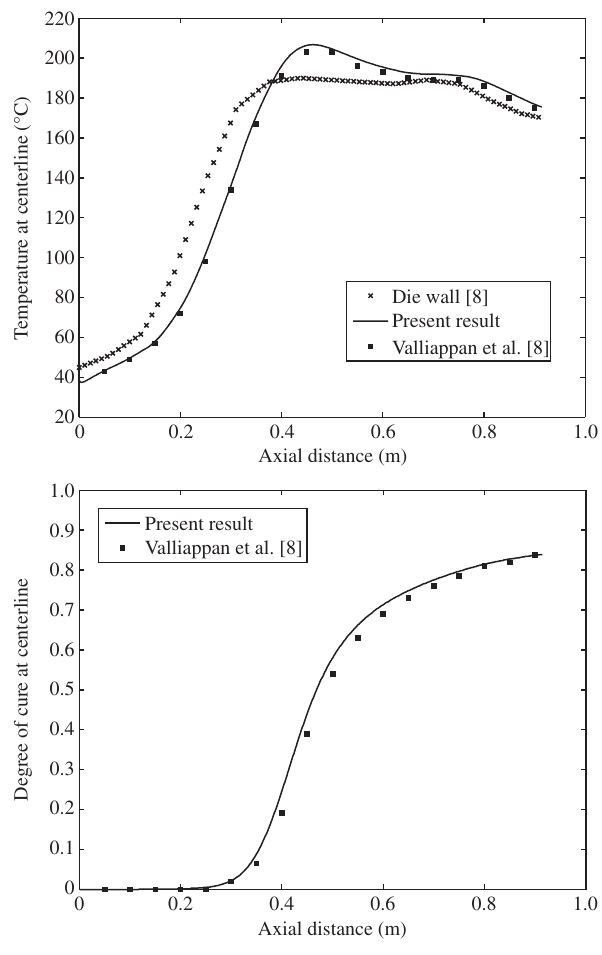
Figure 3 Predicted temperature (top) and degree of cure profiles (bottom) at the centerline of the composite